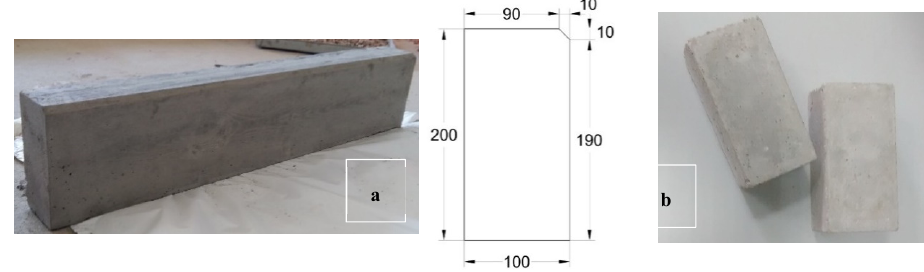
Figure 3. ( a ) General appearance and cross-sectional dimensions (mm) of the recycled curbstone. ( b ) General appearance of the recycled paving blocks.